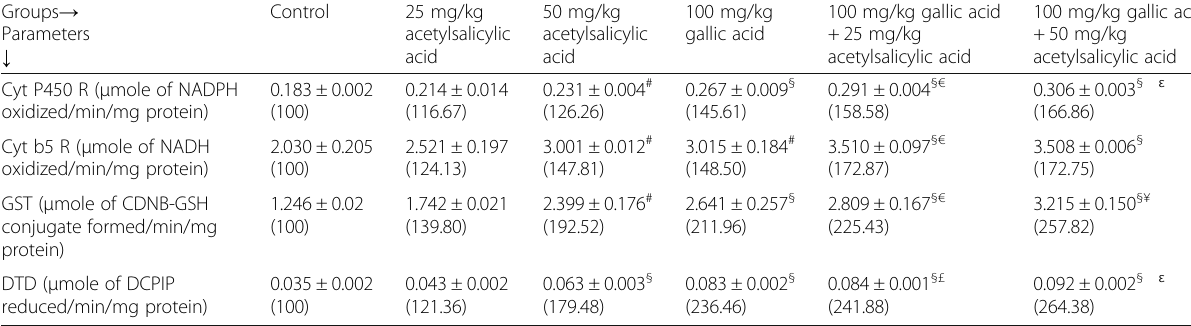
Table 2 Inductive effects of gallic acid, acetylsalicylic acid and their combinations on the specific activities of hepatic phases I and II drug metabolizing enzymes in mice Groups →